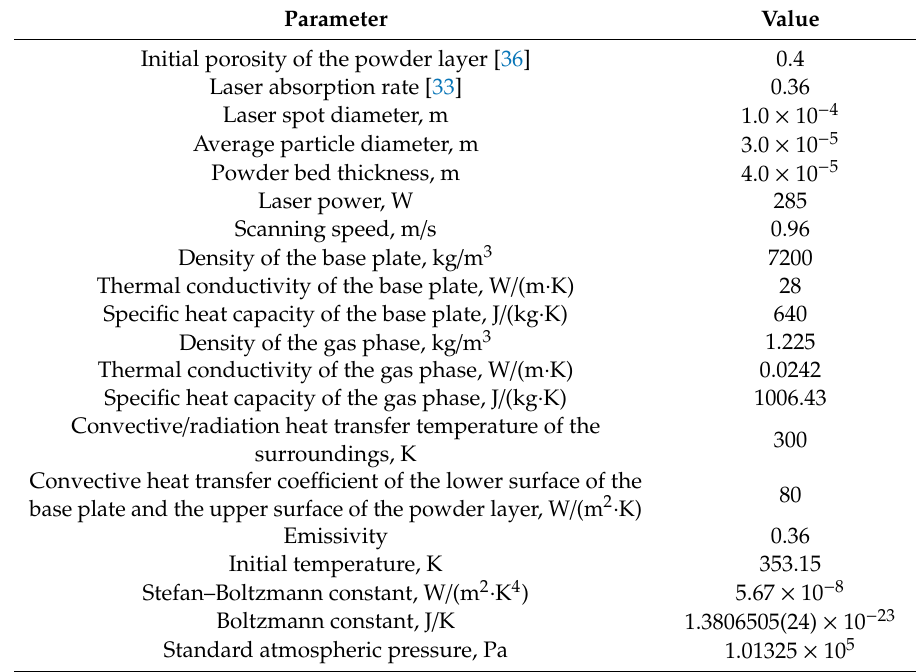
Table 2. Other required calculation